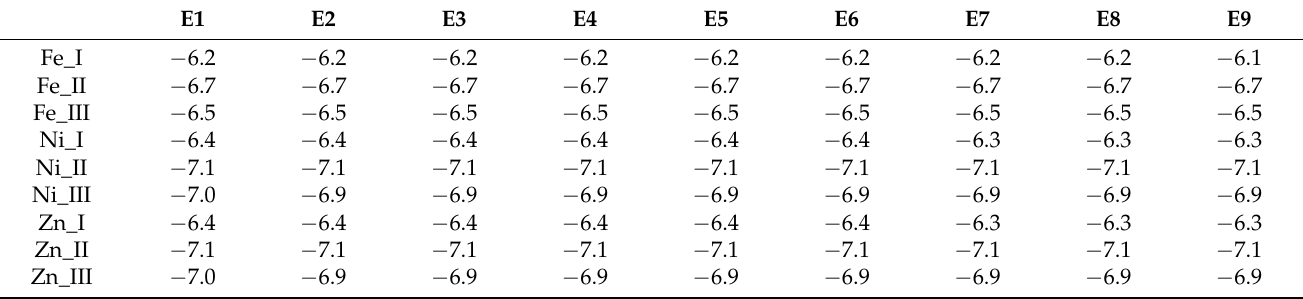
Table 14. Binding affinity for metal-phthalocyanines with C 46 N 3 P 3 (B) for nine conformations (kcal/mol).